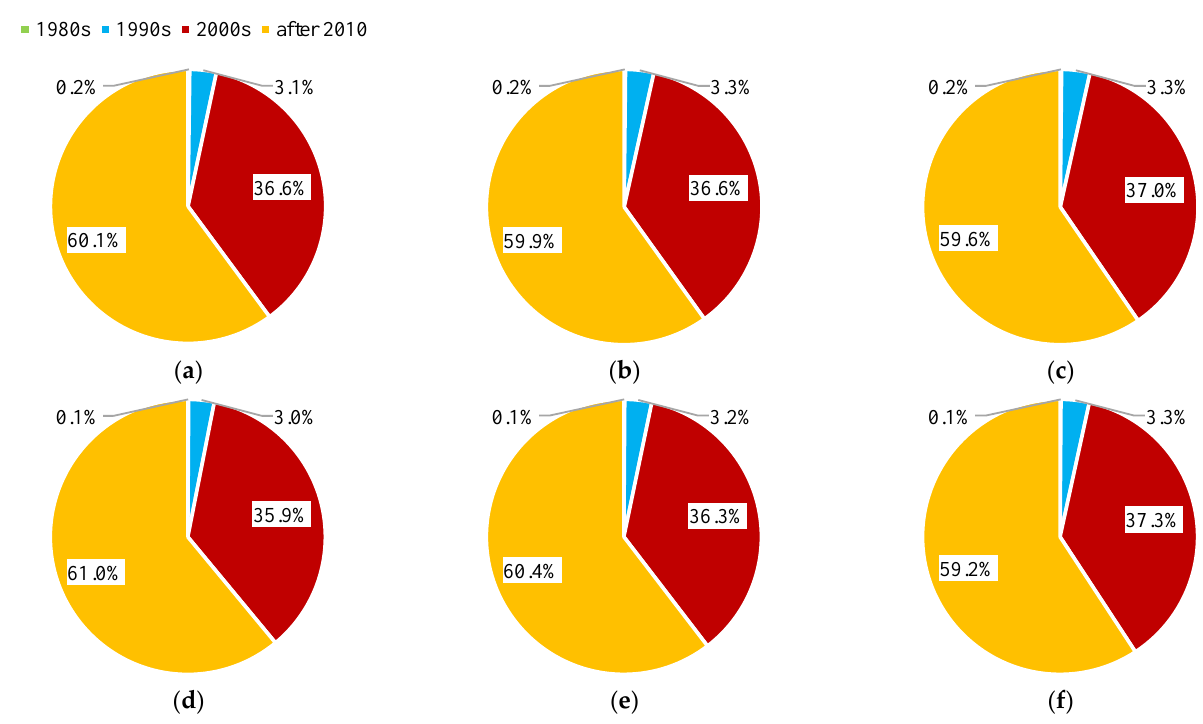
Figure 10. Seismic loss compositions of buildings of different construction years. ( a ) SLE before retrofitting; ( b ) DBE before retrofitting; ( c ) MCE before retrofitting; ( d ) SLE after retrofitting; ( e ) DBE after retrofitting; ( f ) MCE after retrofitting.